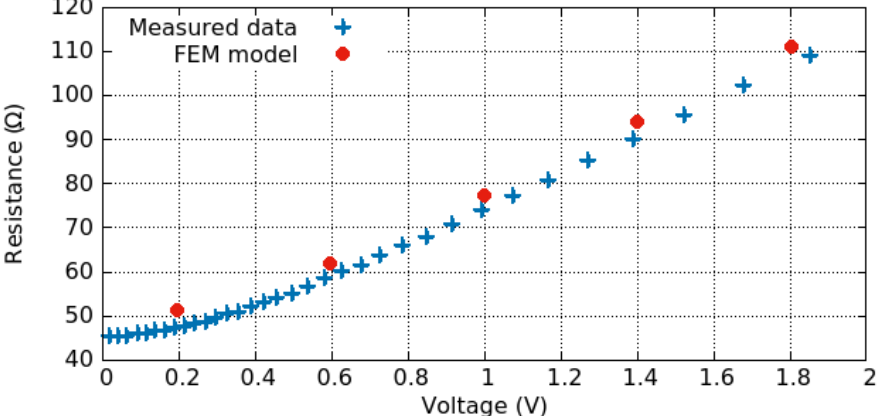
Figure 7. Resistance of the conductive layer of the sensor at different applied